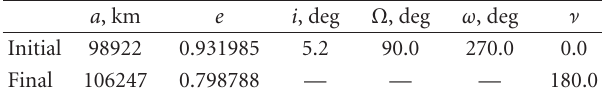
Table 1: Initial and final orbit